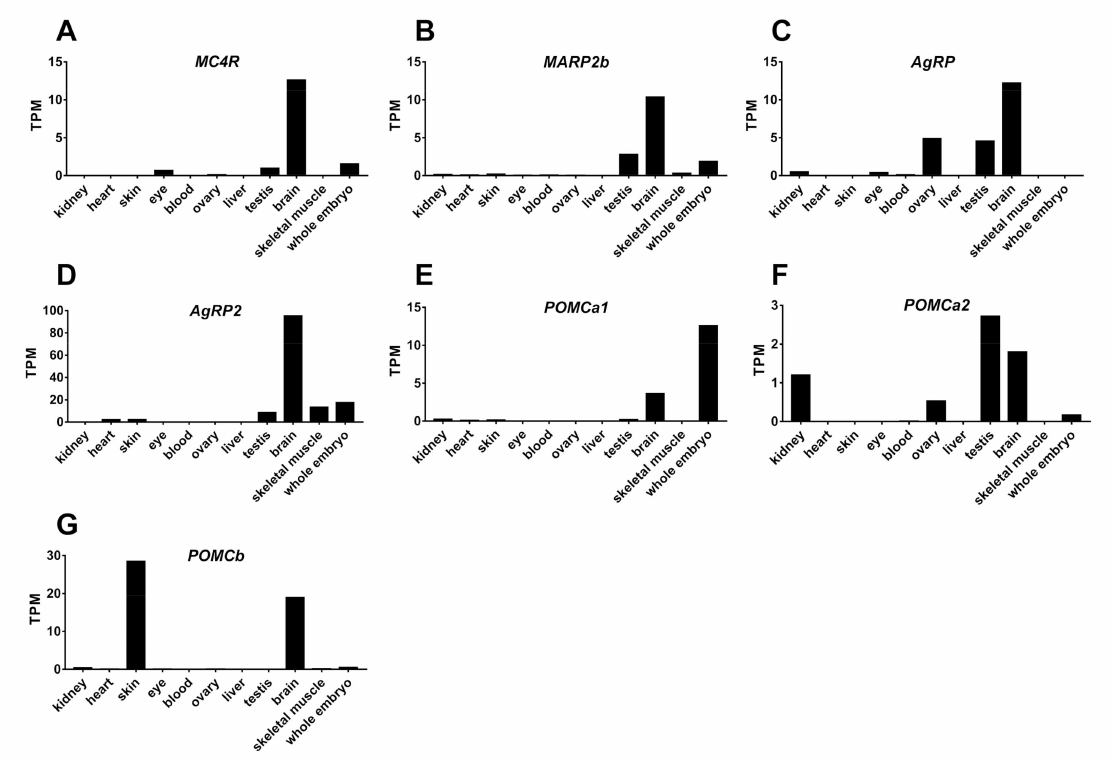
Figure 9. RNA-seq analysis of MC4R , MRAP2b , AgRP , AgRP2 , POMCa1 , POMCa2, and POMCb expression in tilapia tissues. ( A – G ) The expression levels of MC4R ( A ), MRAP2b ( B ), AgRP ( C ), AgRP2 ( D ), POMCa1 ( E ), POMCa2 ( F ), and POMCb ( G ) mRNA were estimated using the RNA-Seq data (Bioproject PRJNA255848, INRA, France) from tilapia tissues including the kidneys, heart, skin, eyes, blood, ovaries, liver, testes, brain, skeletal muscle, and whole embryos. All data were calculated as TPM (transcript per